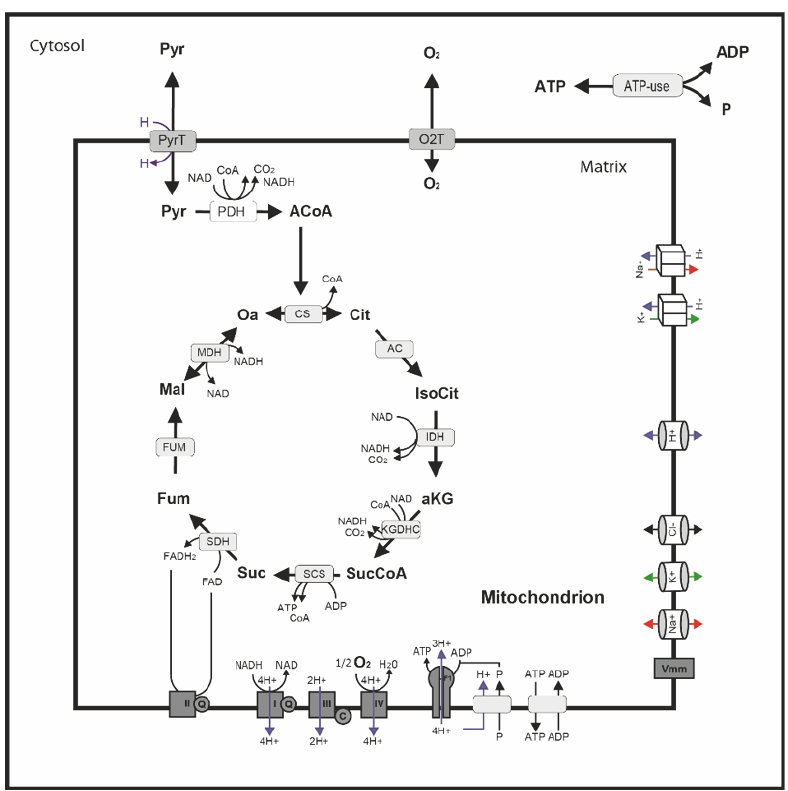
Figure 1: Schematic of the mathematical model. Pyruvate is the only substrate of the TCA cycle. Pyruvate is decarboxylated by pyruvate dehydrogenase (PDH) to acetyl-CoA, which is then condensed with oxalacetate to citrate via the citrate synthase (CS). Citrate is converted into isocitrateby the aconitase (AC), which is further converted to 𝛼 -ketoglutarate via the isocitrate dehydrogenase (IDH) producing NADH from NAD in the process. The 𝛼 -ketoglutarate dehydrogenase complex (KGDHC) catalyzes the reaction of 𝛼 -ketoglutarate with Coenzym A to succinyl-CoA under reduction of NAD to NADH. Succinyl-CoA is further metabolized by succinyl-CoA synthase (SCS) to succinate by phosphorylating ADP to ATP (substrate-chain phosphorylation). Succinate is dehydrogenated to fumarate by the succinate dehydrogenase (SDH,complexII)reducingubiquinonetoubiquinol(seelegend,Figure2).Fumarase(FUM)convertsfumarateintomalate,whichisoxidized by malate dehydrogenase (MDH) again producing one NADH and regenerating the initial oxalacetate so the cycle can start over again. In summary,PDH and theTCA cycleproduces oneATP fromADP, oneubiquinol fromubiquinone,andfour NADH from NADwhileoxidizing one pyruvate to three CO 2 . Oxidation of NADH and/or succinate in the respiratory chain is coupled to transmembrane proton pumping which generates a proton gradient and a mitochondrial membrane potential. The proton gradient is used to fuel pyruvate uptake from the cytosol into the matrix via pyruvate transporter, pumping of sodium, potassium from the matrix into the intermembrane space /cytosol, phosphate transport from the cytosol into the matrix space, and ATP generation by the F0F1-ATPase.The mitochondrial membrane potential drives the ATP/ADP exchang e between the matrix and the intermembrane space /cytosol. The model also comprises the passive exchange of protons, sodium, potassium, and chloride between the matrix and the intermembrane space/cytosol driven by electro diffusion as well as the mitochondrial membrane potential. Cytosolic ATP is hydrolyzed to ADP and phosphate to meet the energy demand of the